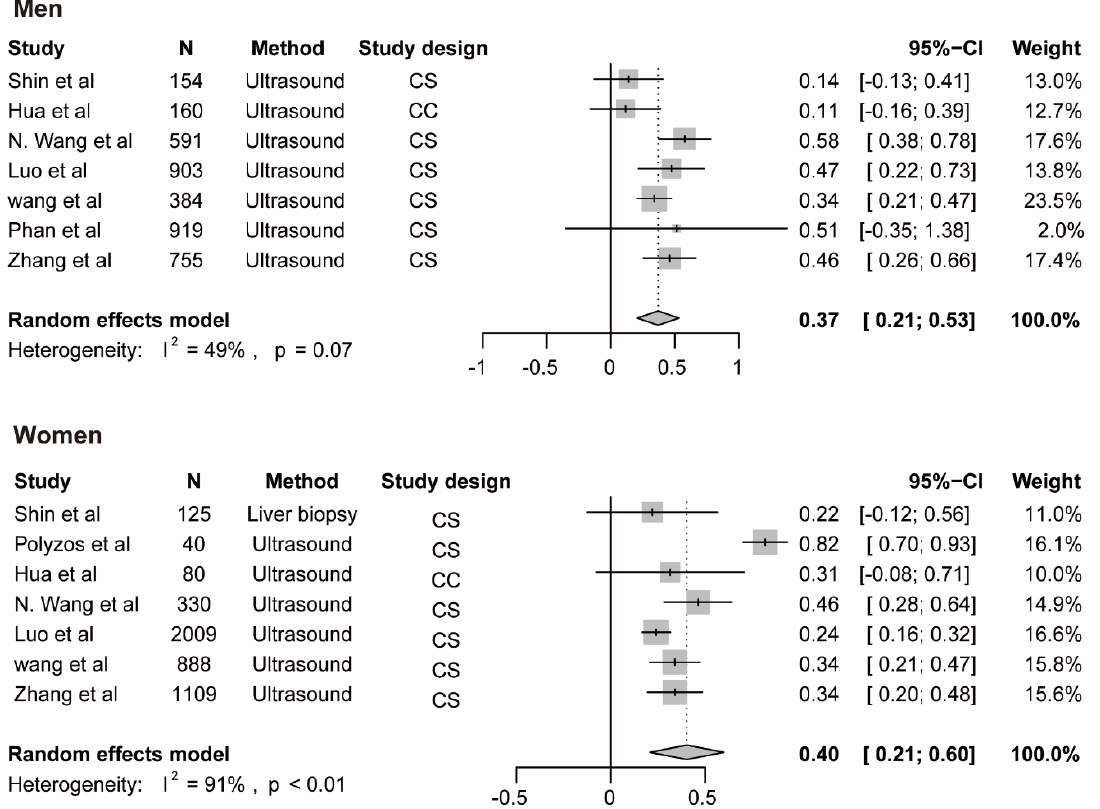
Figure 4. Association of SHBG with NAFLD. The summary estimate (center of diamond) and 95% confidence interval (width of diamond) were synthesized by using a random effect model which is shown in bold. Abbreviations: NAFLD, non-alcoholic fatty liver disease; SHBG, sex hormone-binding globulin.